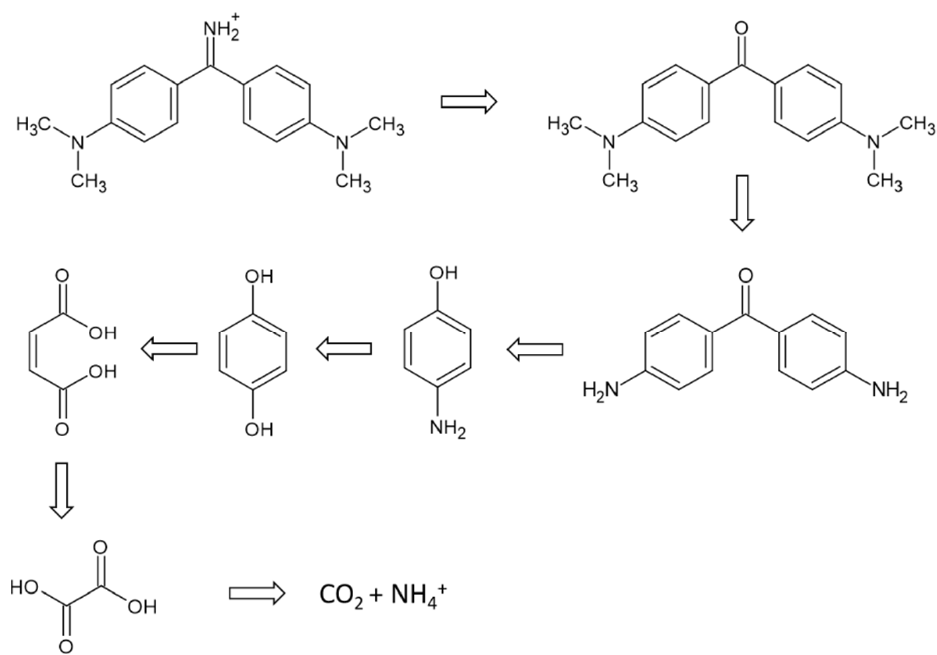
Figure 7. The proposed photodegradation of Auramine O using TiO 2 NPs catalyst.